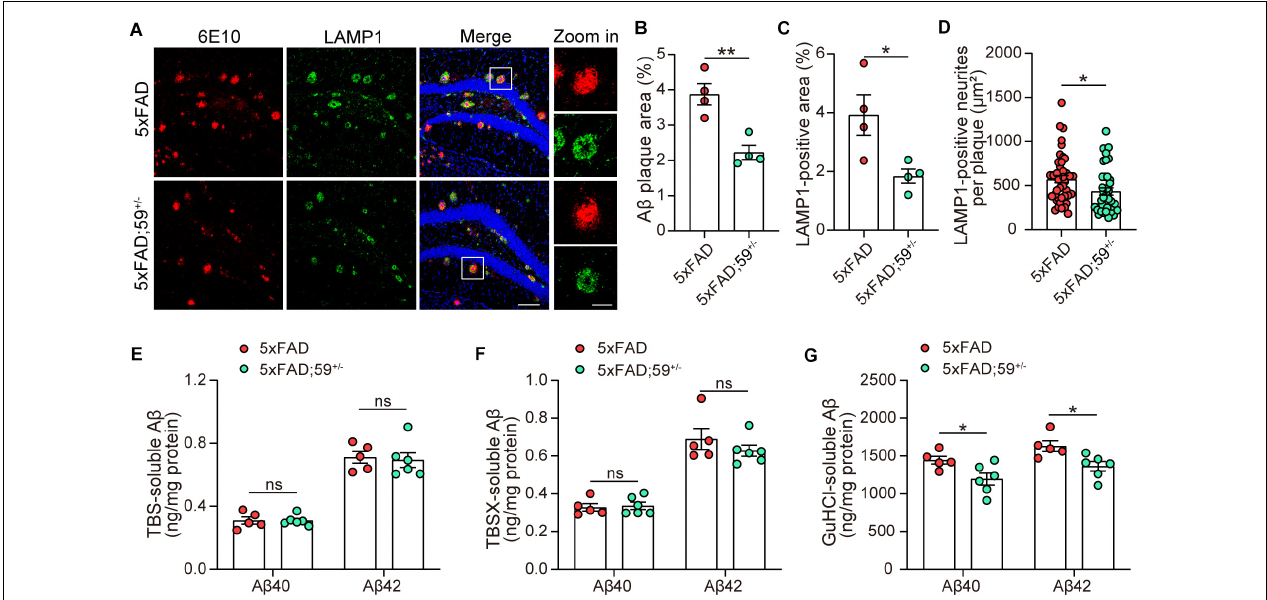
FIGURE 4 | TMEM59 haploinsufficiency reduces A β plaque deposition and neurite dystrophy in 5xFAD mice. (A) Z-stack confocal images of A β plaques (in red) and dystrophic neurites (indicated by LAMP1, in green) in the coronal sections from 6 to 7 month-old 5xFAD and 5xFAD; 59 + / − mice. Original magnifications are 20 × , scale bar, 100 µ m. Zoom-in images are on the right, scale bar, 30 µ m. (B,C) Quantifications and comparisons of the total area of A β plaques (B) and LAMP1-positive dystrophic neurites (C) shown in (A) . n = 4 mice per group. (D) Quantifications and comparisons of the area of A β -associated LAMP1-positive dystrophic neurites per plaque shown in (A) . 43 plaques from four 5xFAD mice and 40 plaques from four 5xFAD; 59 + / − mice were studied for analysis. (E–G) The levels of A β 40 and A β 42 in the hippocampus of TBS-extractions (E) , TBSX-extractions (F) , and GuHCl-extractions (G) from 8 month-old 5xFAD and 5xFAD; 59 + / − mice were measured by ELISA and compared. n = 5 mice for 5xFAD, n = 6 mice for 5xFAD; 59 + / − . Data represent mean ± SEM. * p < 0.05, ** p < 0.01, ns: not significant. Unpaired t -test.